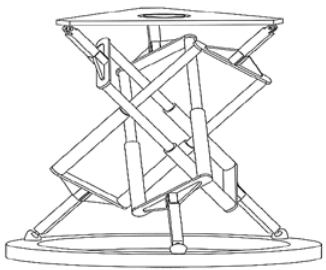
Figure 14. The first type of optimized structure.